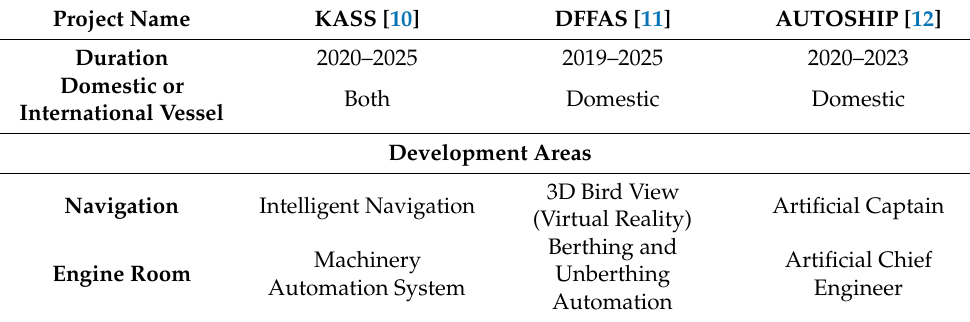
Table 2. Global MASS projects and their key development